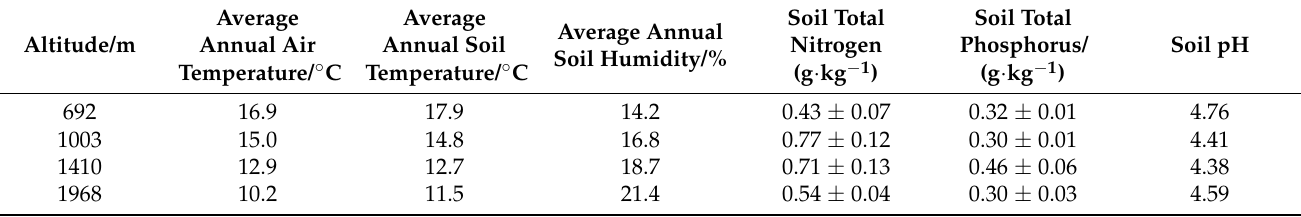
Table 2. Basic information of different altitudes gradient test sites.